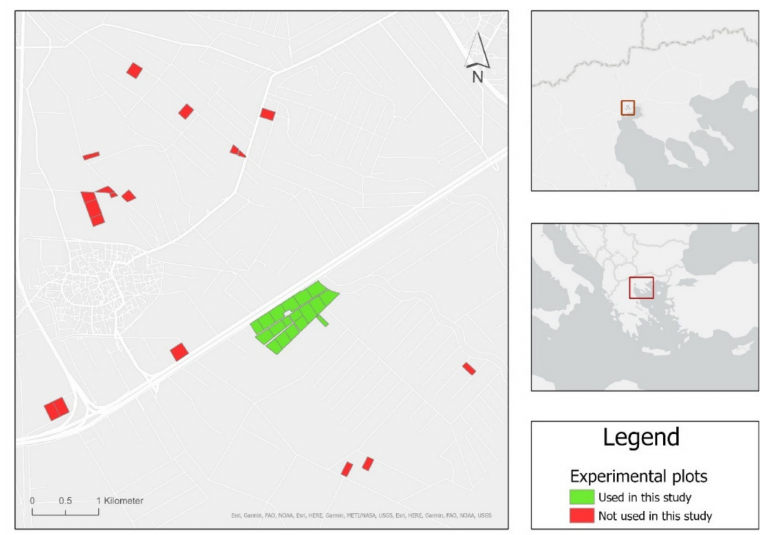
Figure 1. Map of study area and rice fields.